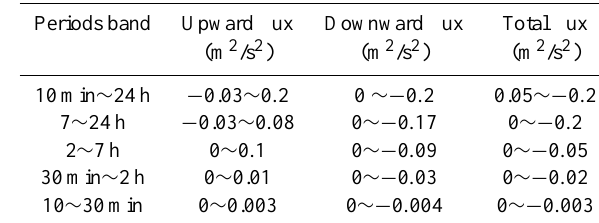
Table 2. The 1st 24h (quiet day) average upward flux and down- ward flux of zonal momentum in the height 6 ∼ 17km for different wave periods band.